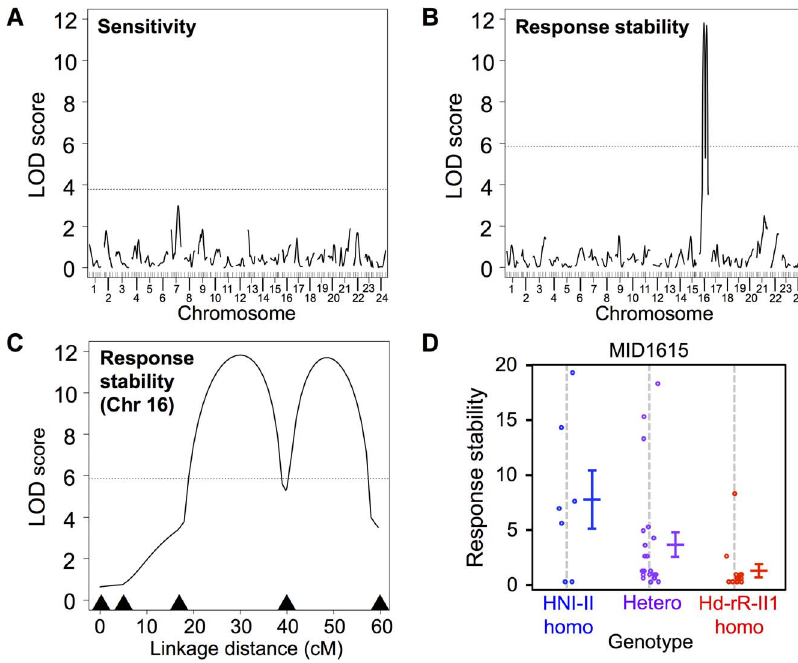
Figure 4. Quantitative Trait Analysis with F2 between HNI-II and Hd-rR-II1. In A, B, and C, dashed lines indicate the thresholds (p=0.05). (A) QTL analysis on sensitivity. No significant QTL was detected. (n=87) (B) QTL analysis on response stability index. Significant QTL was detected on chromosome 16. (n=78) (C) QTL analysis on response stability index. The result of chromosome 16 is shown. Black arrowheads indicate marker positions. (D) Genotype-phenotype relationship at a polymorphic marker located at 39.75-cM on linkage group 16, corresponding to chromosome 16.